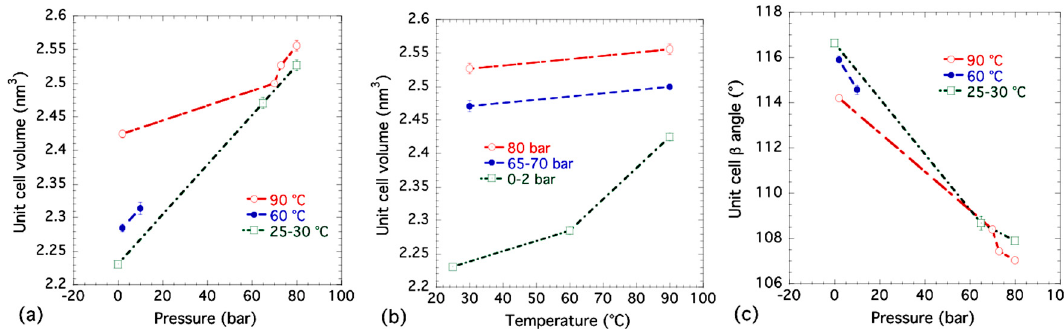
Figure 6. Variation of NiBpene unit cell parameters with CO 2 pressure and temperature: ( a ) unit cell volume, V, versus CO 2 pressure, p CO ; ( b ) unit cell volume, V, versus temperature, T; and ( c ) unit cell β angle versus p CO 2 . Vertical bars indicate standard deviation uncertainties for each data point. It appears that at the supercritical pressure (starting at 73 bar, 90 ◦ C), the β angle starts to decrease more strongly with increased pressure while the unit cell volume increases more steeply. Among all Table 1. Estimated unit cell parameters of 9 XRD datasets (sets 1–8 from USAXS/SAXS/WAXS of the eight selected XRD measurements, the β angle is smallest at the highest supercritical pressure measurements and set 9 from powder XRD data taken at room temperature and ambient pressure.). used at 80 bar, even though it is still larger than the 97 ◦ found in the previous single crystal study where DMSO was the sorbate [44]. It is conceivable that the Bpene ligands interact with the DMSO molecules to open up the cavities within the NiBpene structure to a greater degree than occurs due to the packing of more polarizable CO 2 molecules. The CO 2 molecules have to align themselves to maximize their packing density within the structure, as discussed in connection with the DFT results. Even with supercritical CO 2 pressures, the unit cell does not attain as high a volume as that found in the single crystal study with DMSO as the sorbate and with an extra Bpene ligand. This may simply be due to larger molecular cross sections for DMSO and Bpene guests compared to CO 2